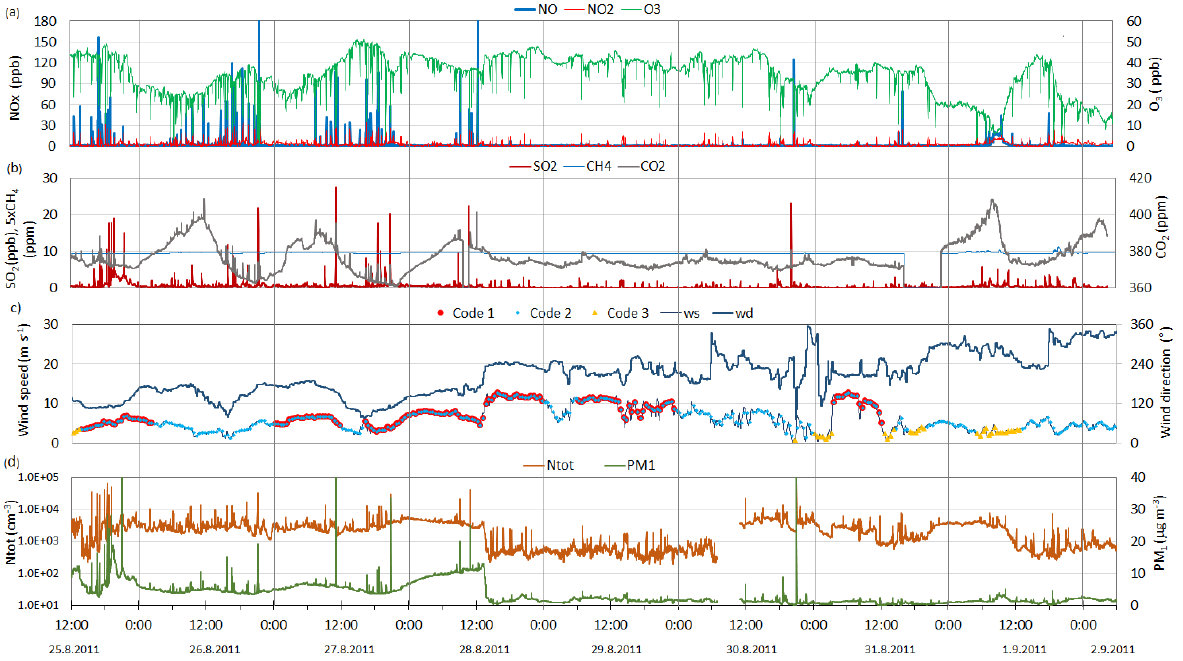
Figure 4. Time series of 1min average concentrations of gaseous (a–b) and particulate matter (d) as well as the wind speed and wind direction (c) during the period from 25 August to 2 September 2011. Also shown in panel (c) is the 30min average wind speed in different situations with respect to M–O theory (i.e., codes 1 to 3).